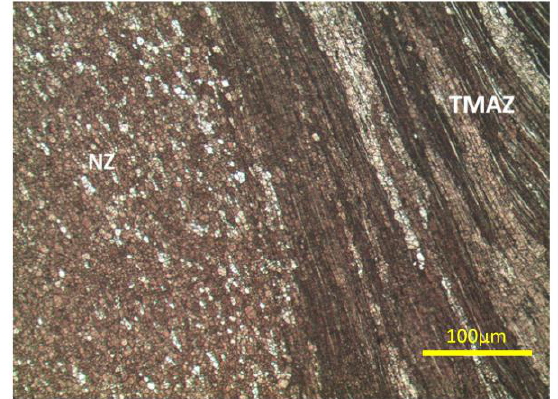
Figure 9. Optical image of NZ and TMAZ (110 mm/min) 100X.